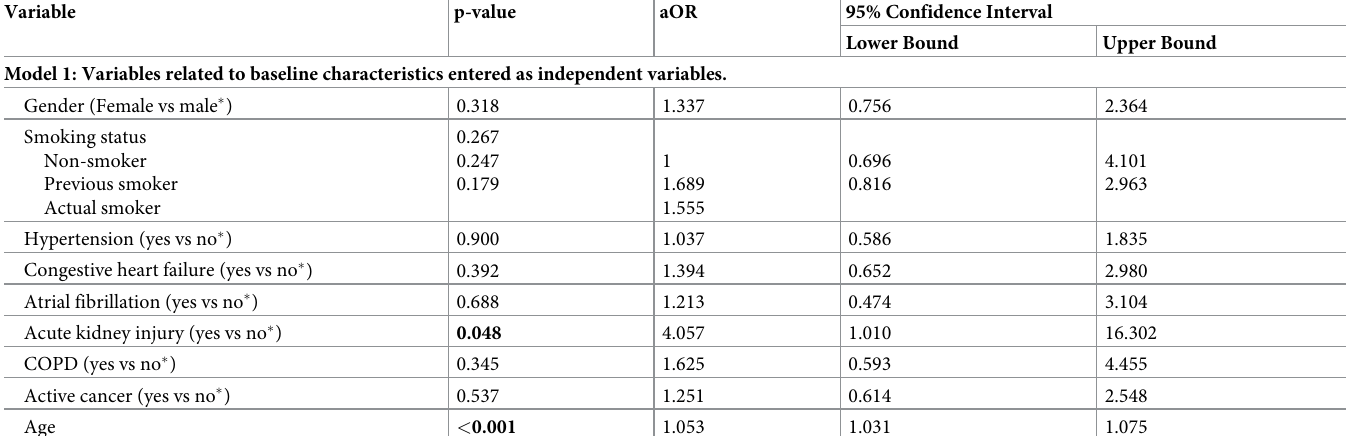
Lower Bound Upper Bound